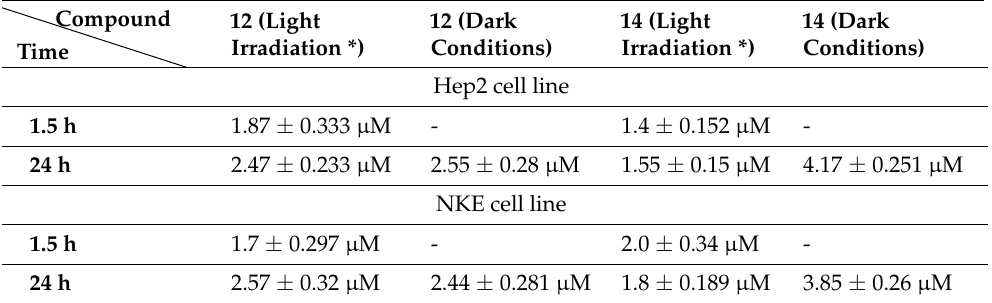
Table 4. IC 50 of compounds 12 and 14 for the Hep2 and NKE cell lines.